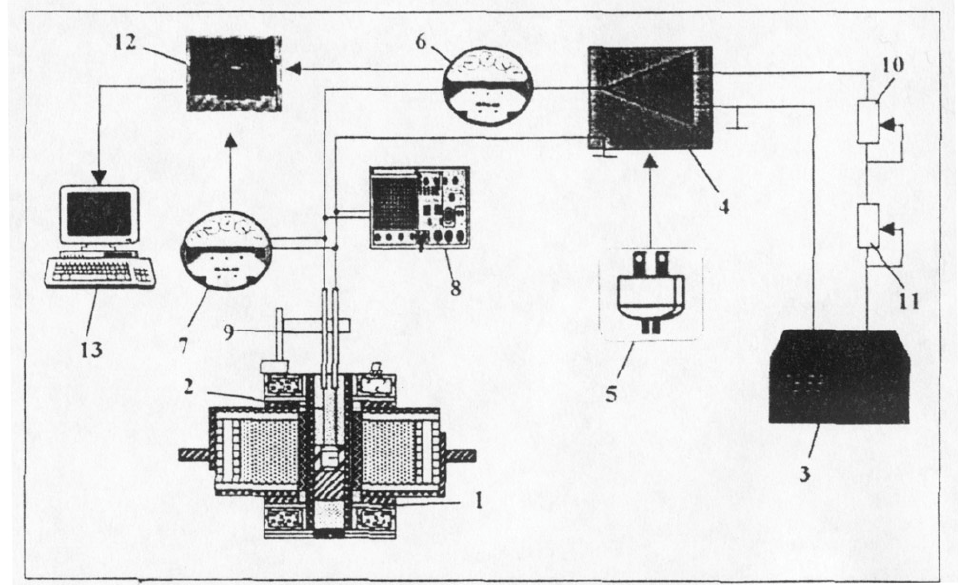
Figure 4. Scheme of the installation for determining electrical conductivity. 1—Tamman oven; 2— Tungsten electrodes; 3—de-frequency generator; 4—alternating current ampli fi er; 5—DC power